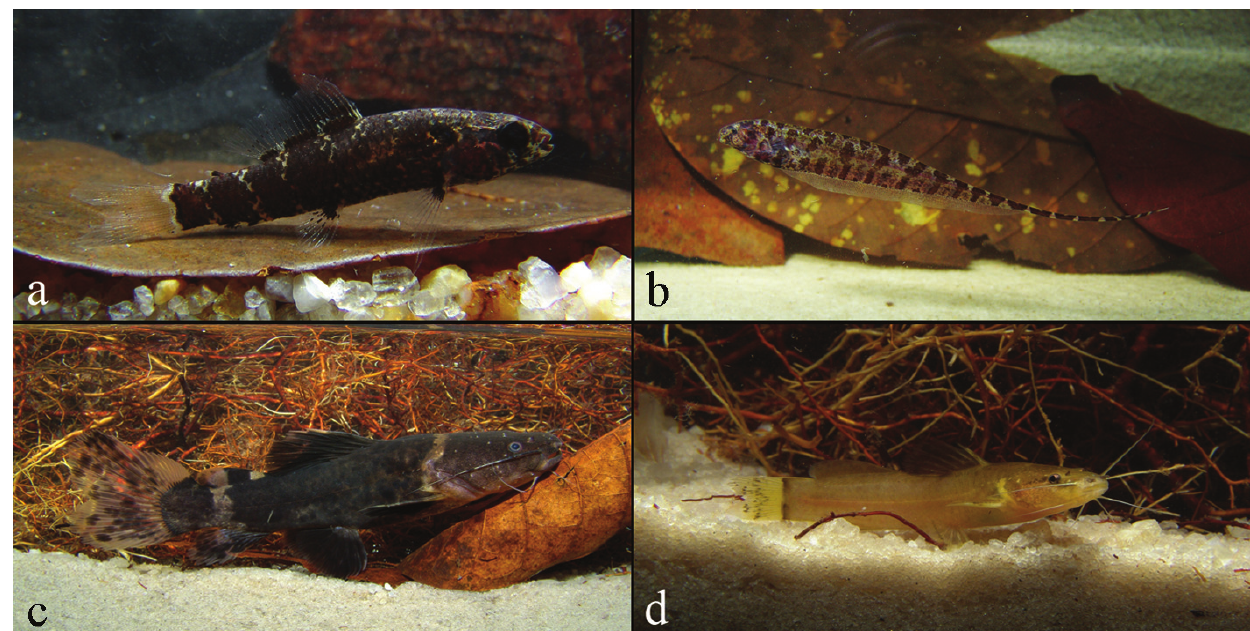
Fig. 3. The fish fauna associated with kinon banks is dominated by species of characins (Characiformes), catfishes (Siluriformes) and electric knife fishes (Gymnotiformes). Some of the more common and abundant species in our samples were the following: ( a ) Elachocharax pulcher , Crenuchidae; ( b ) Hypopygus lepturus , Hypopomidae; ( c ) Batrochoglanis raninus , Pseudopimelodidae; and ( d ) Brachyglanis microphthalmus ,